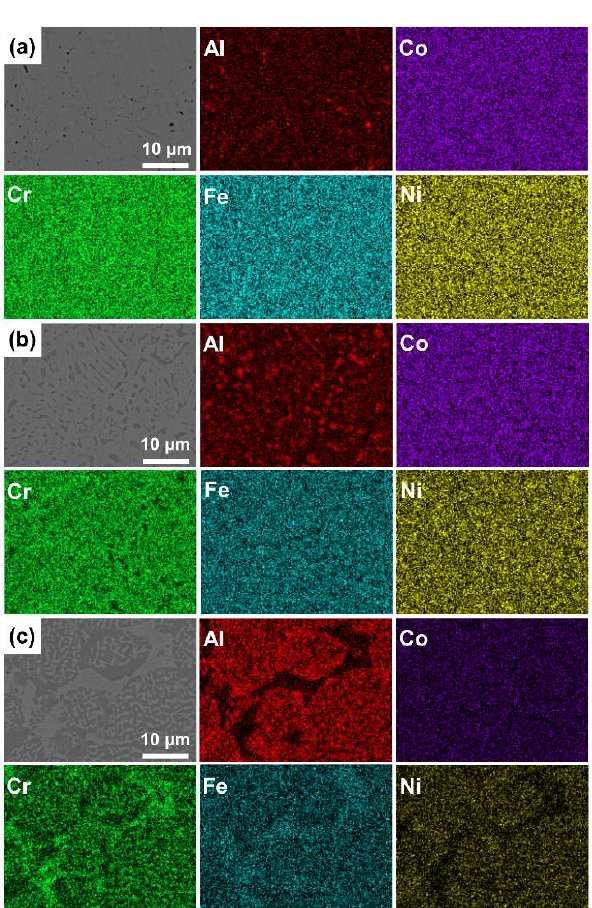
Figure 3. The elemental mapping of the of AlxCoCrFeNi HEAs: ( a ) Al0.2CoCrFeNi, ( b ) Al0.5CoCrFeNi, and ( c ) AlCoCrFeNi. The elemental distribution of Al, Co, Cr, Fe, and Ni are shown in red, purple, green, blue, and yellow,